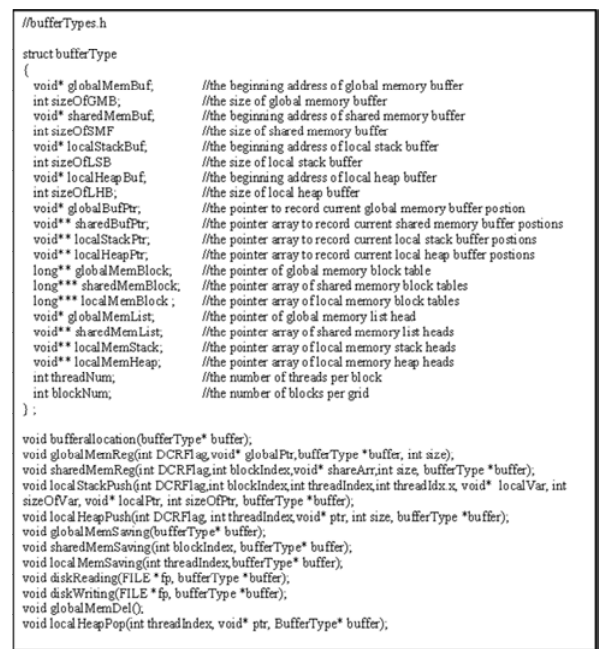
Fig. 5. The content of the file